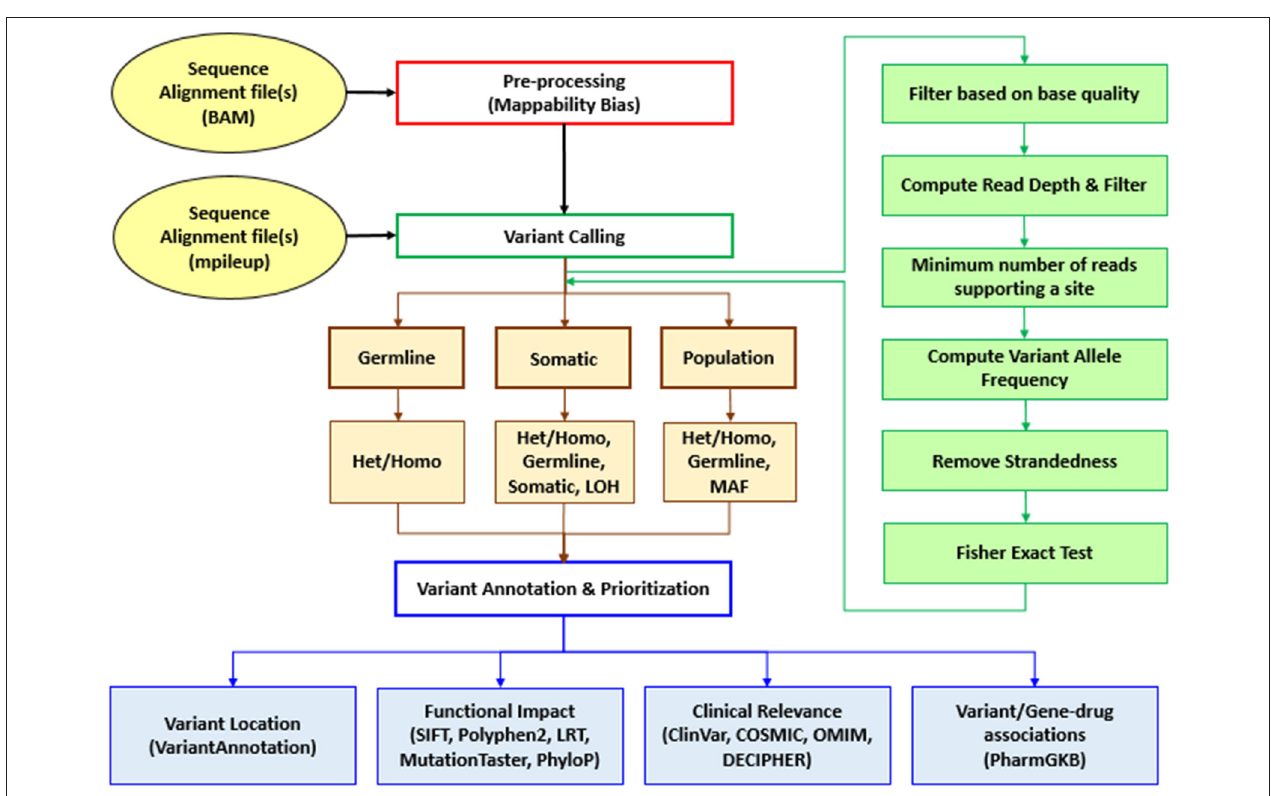
FIGURE 1 | Workflow of SeqVItA for identification, annotation and prioritization of sequence variants in WGS, WES, or TS data. Het, Heterozygous; Homo, Homozygous; LOH, Loss of heterozygosity; MAF, Minor allele frequency.